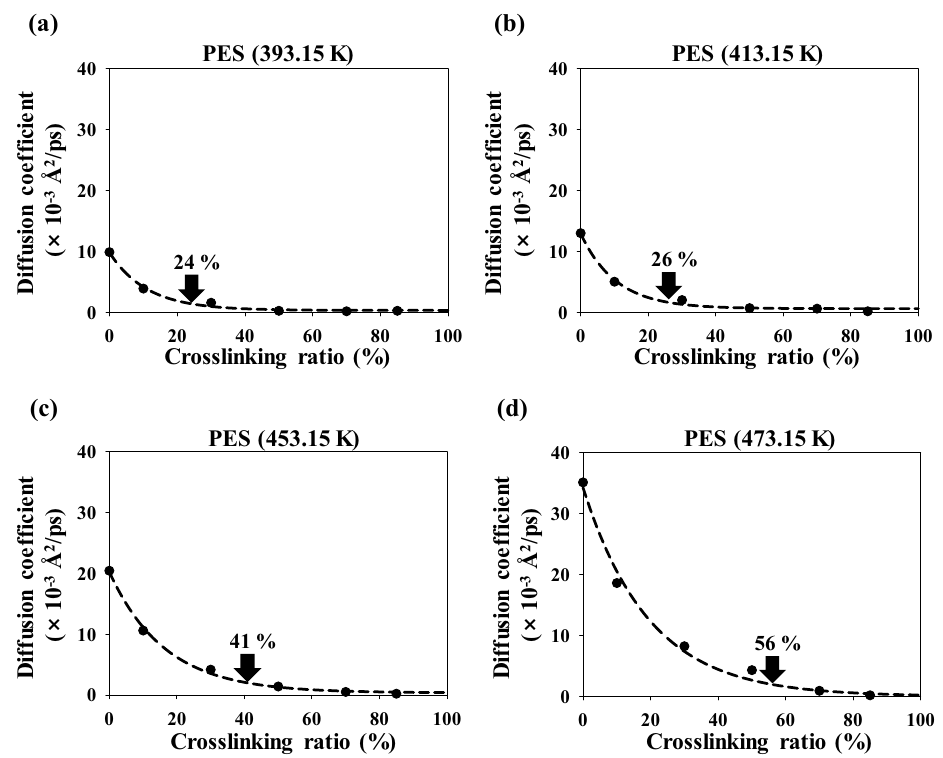
Figure 5. Diffusion coefficient of PES at ( a ) 393.15 K, ( b ) 413.15 K, ( c ) 453.15 K, and ( d ) 473.15